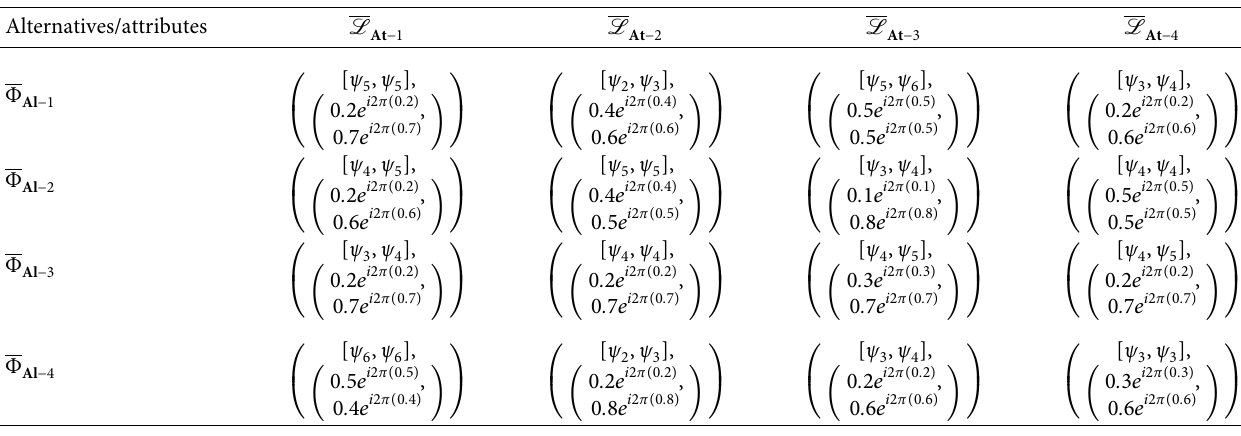
Table 1: Decision matrix in terms of CIULNs provided by expert � R 1 .